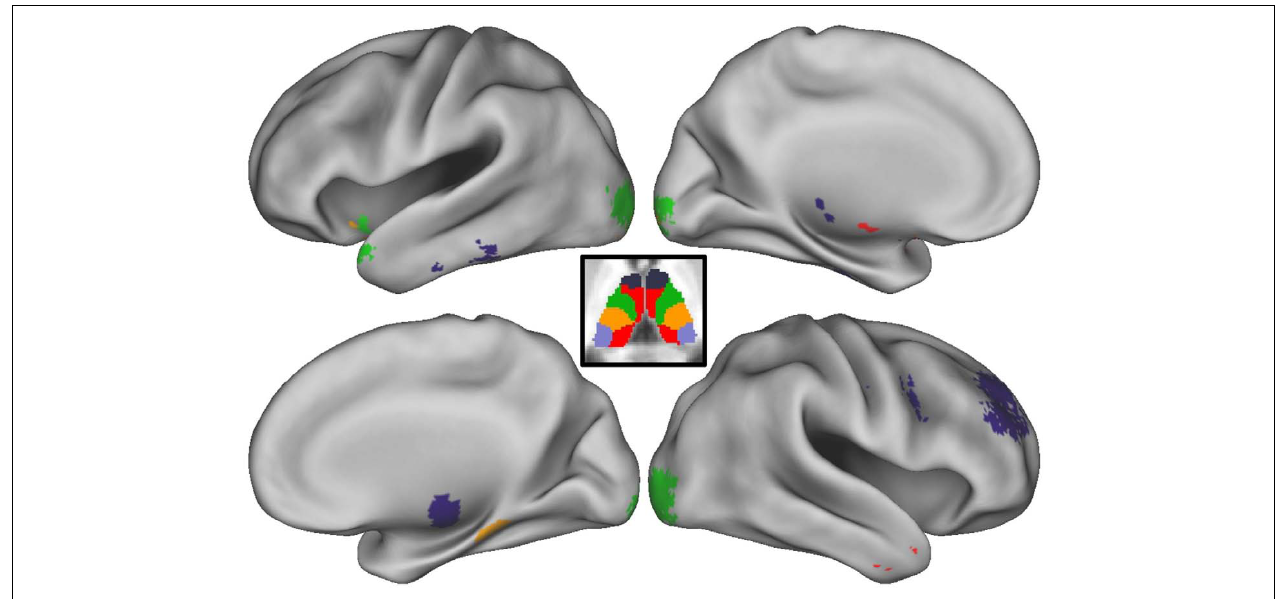
Deep purple corresponds to the prefrontal thalamic ROI, light purple corresponds to the occipital–parietal thalamic ROI, green corresponds to the premotor–motor thalamic ROI, orange–yellow corresponds to the somatosensory thalamic ROI, and red corresponds to the temporal thalamic